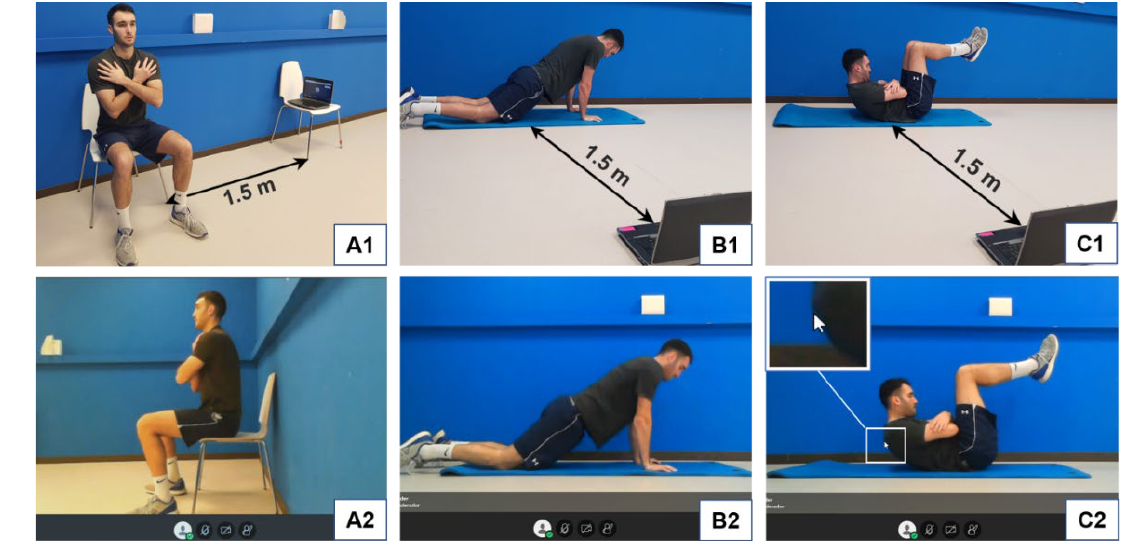
Figure 1. Participant performing the 5-repetition sit-to-stand test ( A1 , A2 ), the kneeling push-up test ( B1 , B2 ) and the Shirado-Ito trunk flexor endurance test ( C1 , C2 ). ( A1 – C1 ) show the positioning of the participant and the material. ( A2 – C2 ) show the screen view of the evaluator. In ( C2 ), the evaluator is using the mouse cursor to accurately assess the position of the trunk.